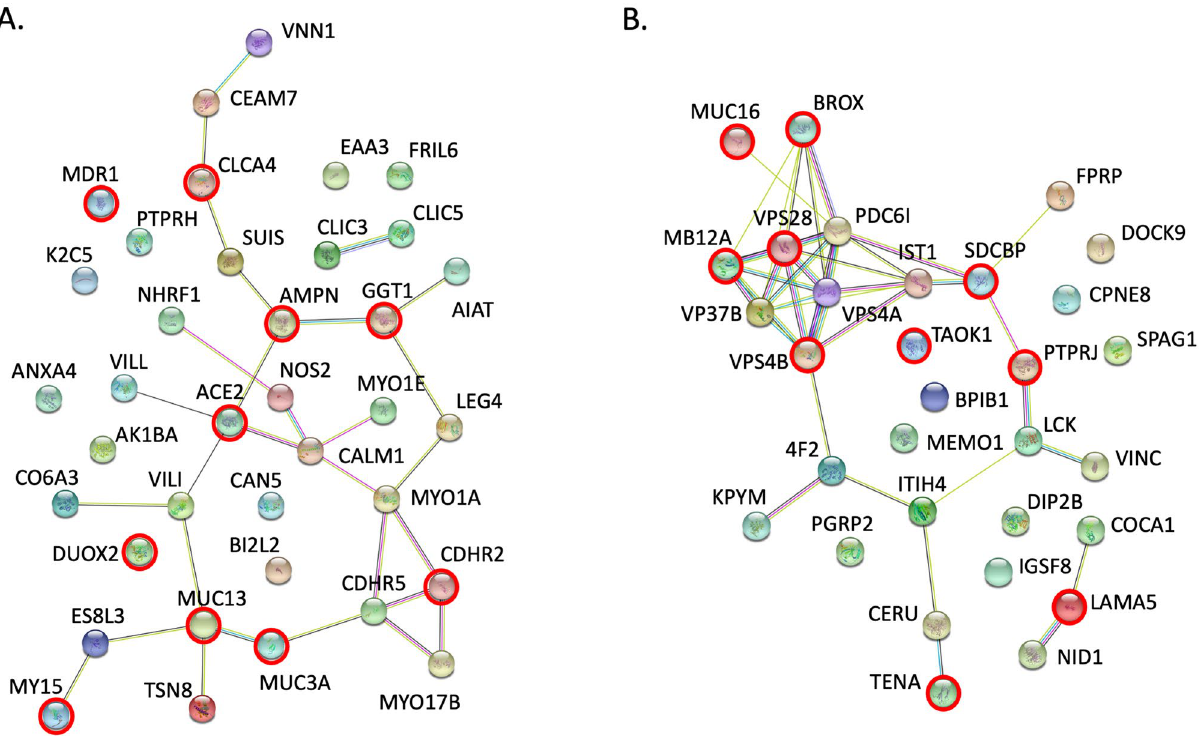
Figure 5. Protein interaction analysis. The STRING database (https:// string- db. org) was used to analyze protein–protein interactions among the candidates found to be upregulated in pancreatic organoid EVs from ( A ) healthy controls or ( B ) PDAC patients. Nodes highlighted with a red ring designate proteins within the top ten highest fold change in each group (p < 0.01, see Fig.